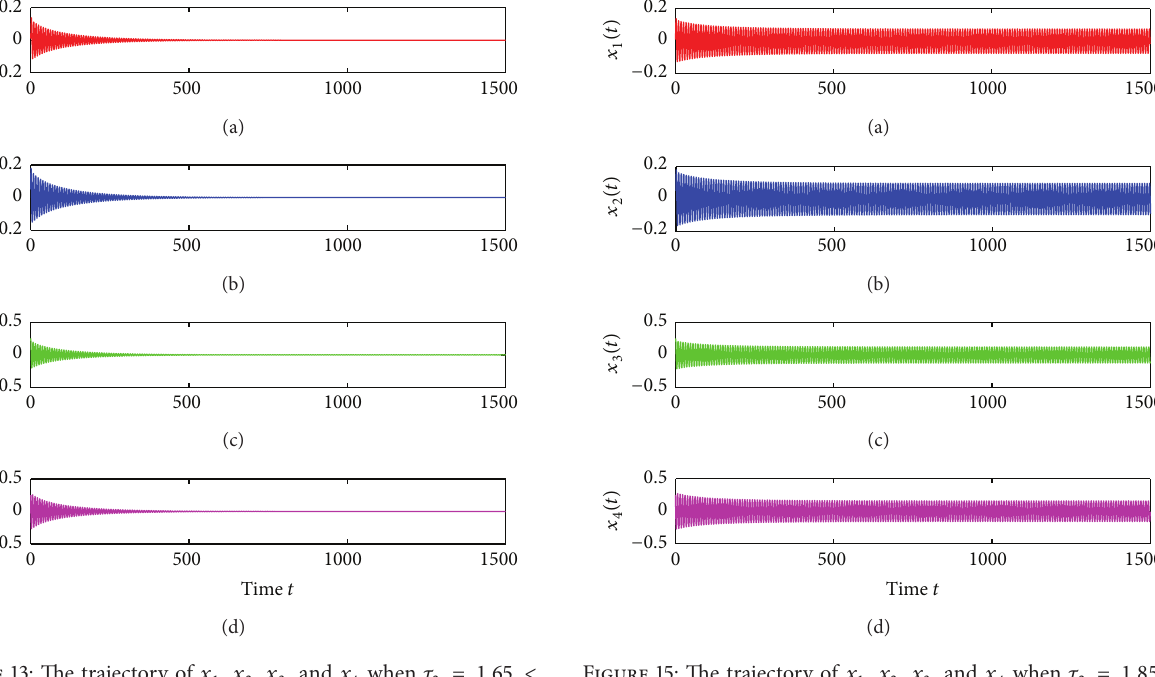
Figure 15: The trajectory of 𝑥 1 , 𝑥 2 , 𝑥 3 , and 𝑥 4 when 𝜏 2 = 1.85 > 𝜏 ∗ = 0.35 . 1.7488 = 𝜏 ∗ 2 and 1